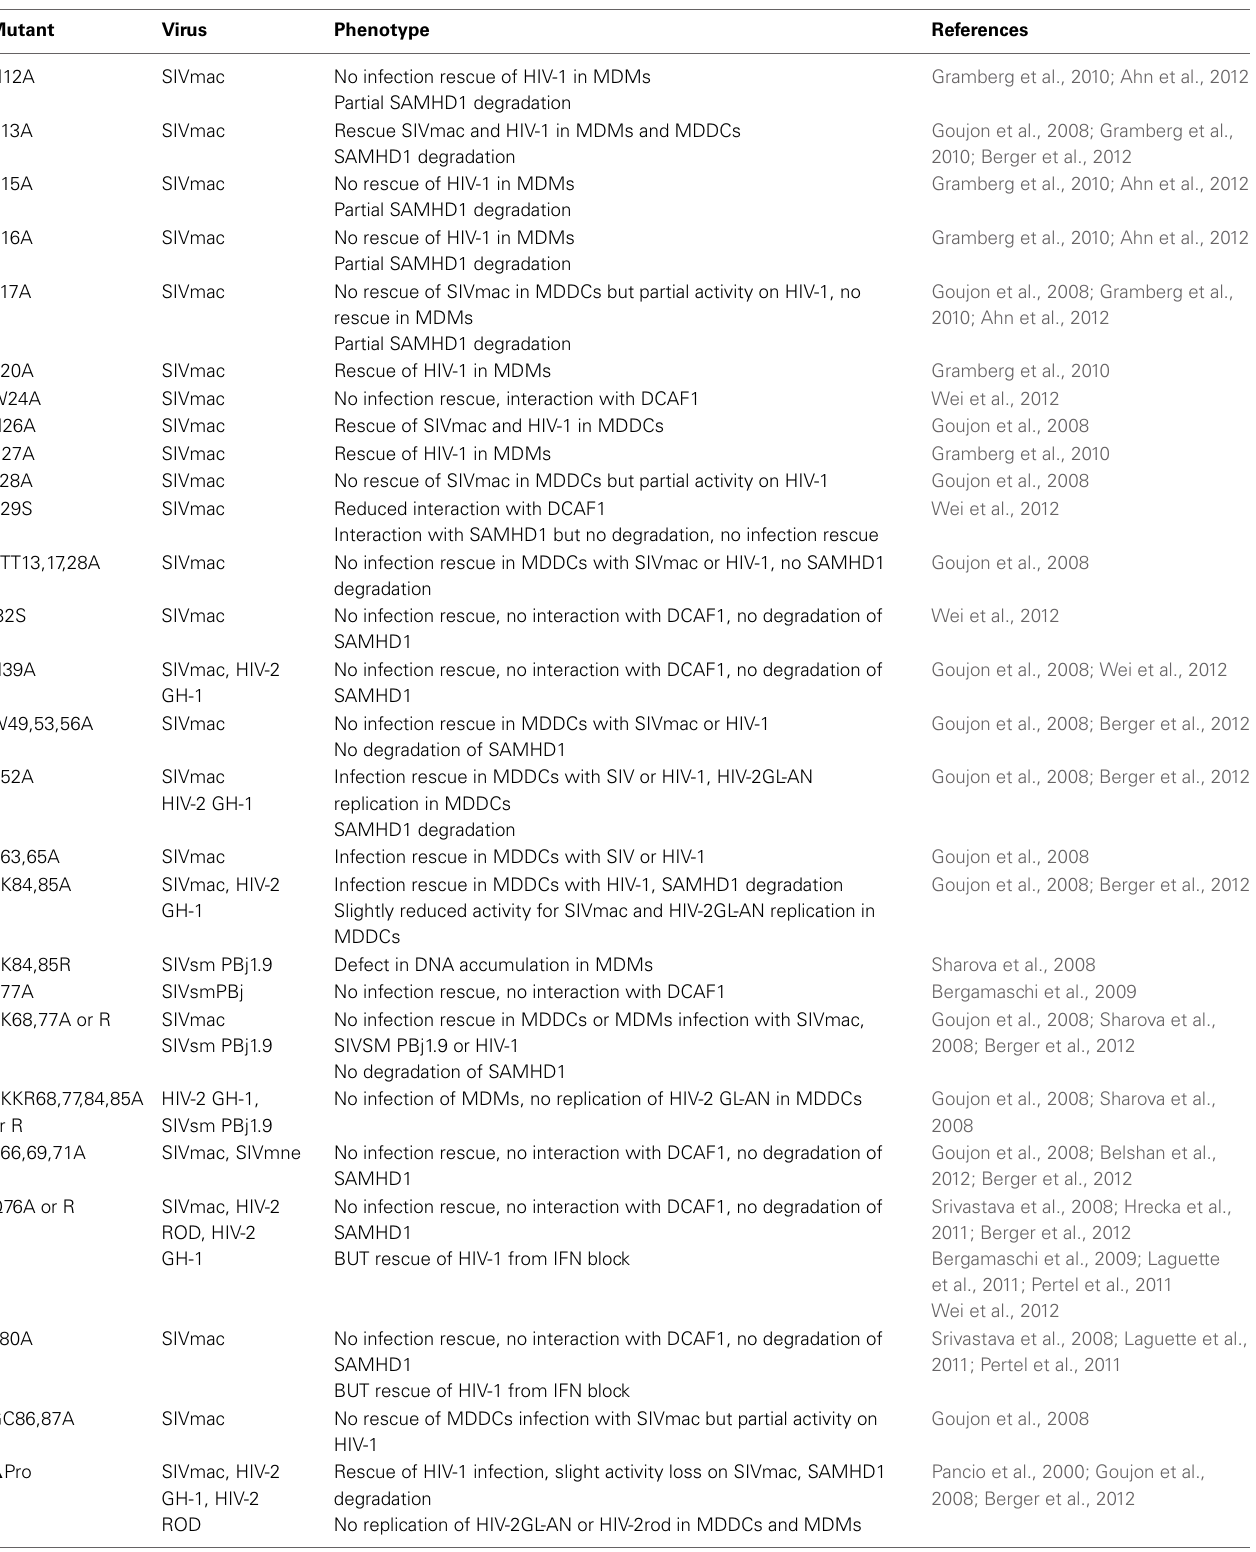
Table 1 | Phenotype of Vpx mutants.